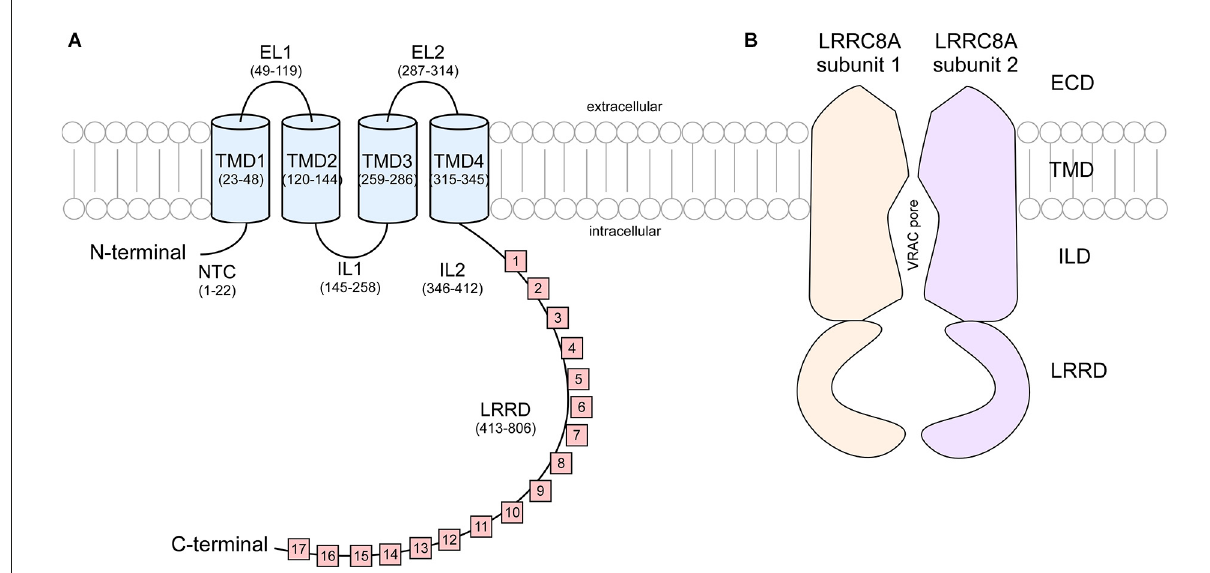
FIGURE2 CartoonrepresentationofLRRC8AsubunitstructureandcrosssectionofVRAC. (A) EachLRRC8AsubunitismadeupofanintracellularN-terminal coil (NTC, residues 1–22), four transmembrane domains (TMD; residues 23–48, 120–144, 259–286, and 315–345) connected by two extracellular loops (EL, residues 49–119 and 287–314) and two intracellular loops (IL, residues 145–258 and 346–412), followed by 15–17 cytoplasmic leucine rich repeats (residues 413–806; Kasuya et al., 2018). (B) Each VRAC is composed of six LRRC8 subunits. This diagram portrays a cross section of an LRRC8A homomer that arranges to produce a hexameric channel with an extracellular domain (ECD), transmembrane domain (TMD). Intracellular linker domain (ILD), and an extensive leucine rich repeat domain